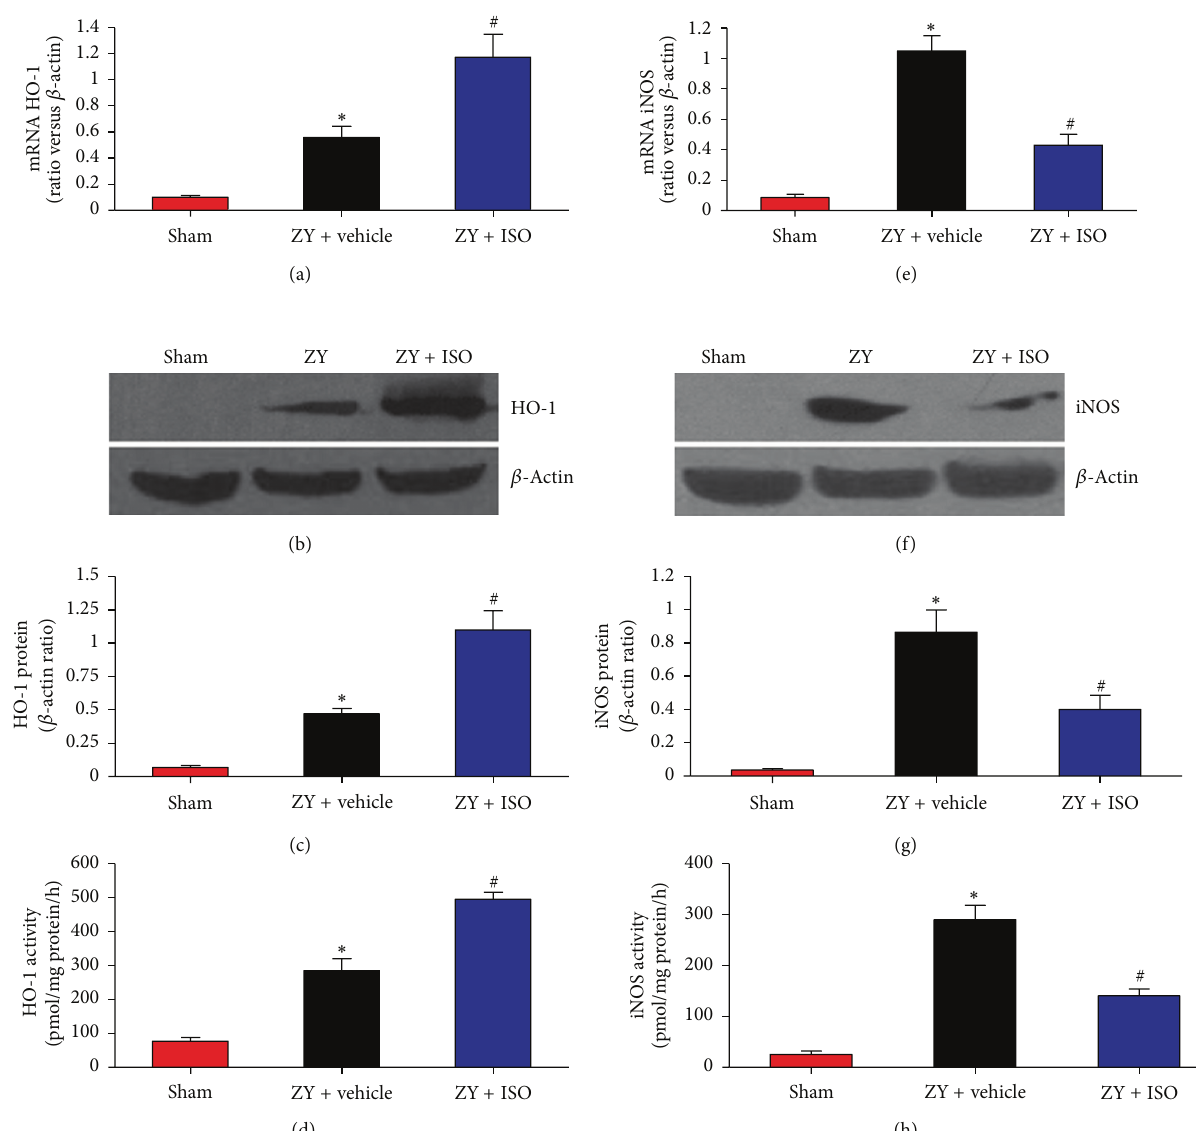
Figure 5: HO-1 activation and iNOS suppression induced by 1.4% ISO treatment in ZY-stimulated lungs. Amplicons were densitometrically quantified,andtherelativeamountsofamplifiedHO-1mRNA(a)andiNOSmRNA(e)werenormalizedagainst 𝛽 -actin;Westernblotanalysis for expression of HO-1 (b) and iNOS (f); protein bands were densitometrically quantified and relative amounts of HO-1 protein (c) and iNOS protein (g) were normalized against 𝛽 -actin; and detection of HO-1 (d) and iNOS (h) enzyme activities. The respective densitometric analysis of mRNA and protein bands is from three separate experiments. The animals were treated as described in Figure 1. Data are mean ± SD ( 𝑛 = 10 mice per group). ∗ 𝑃 < 0.05 versus sham; # 𝑃 < 0.05 versus ZY +